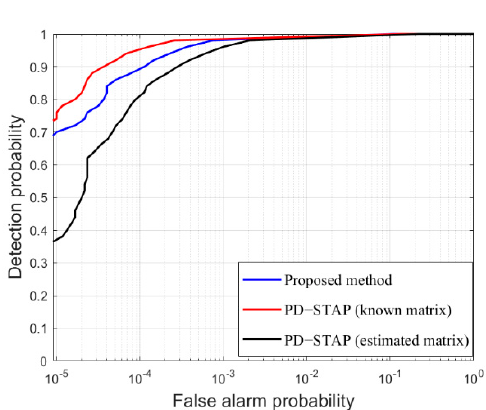
Figure 3. Receiver operating characteristic (ROC) curves.